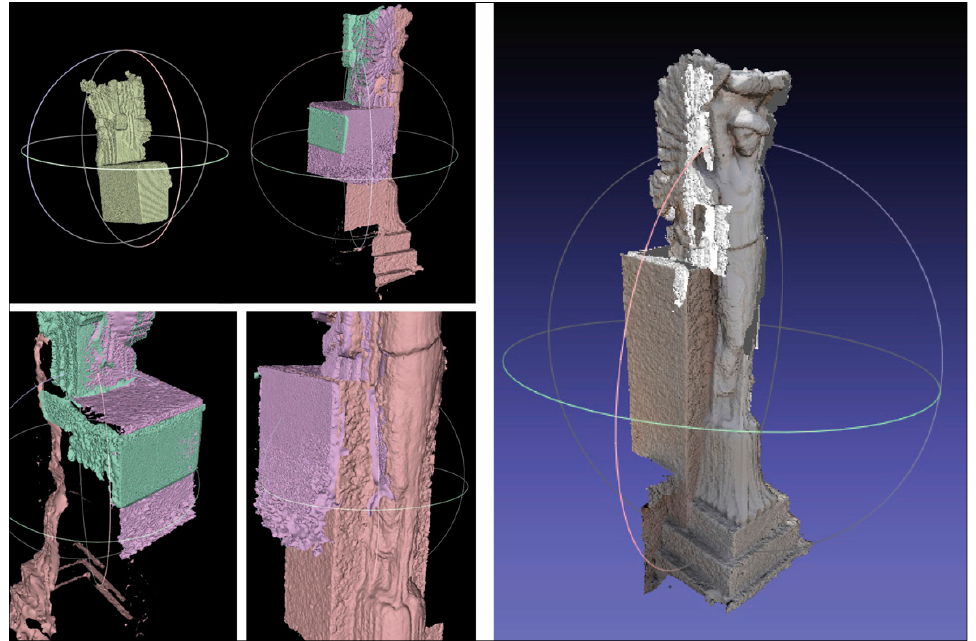
Figure 6. The same points must be recognized in both photo blocks in order to align the two